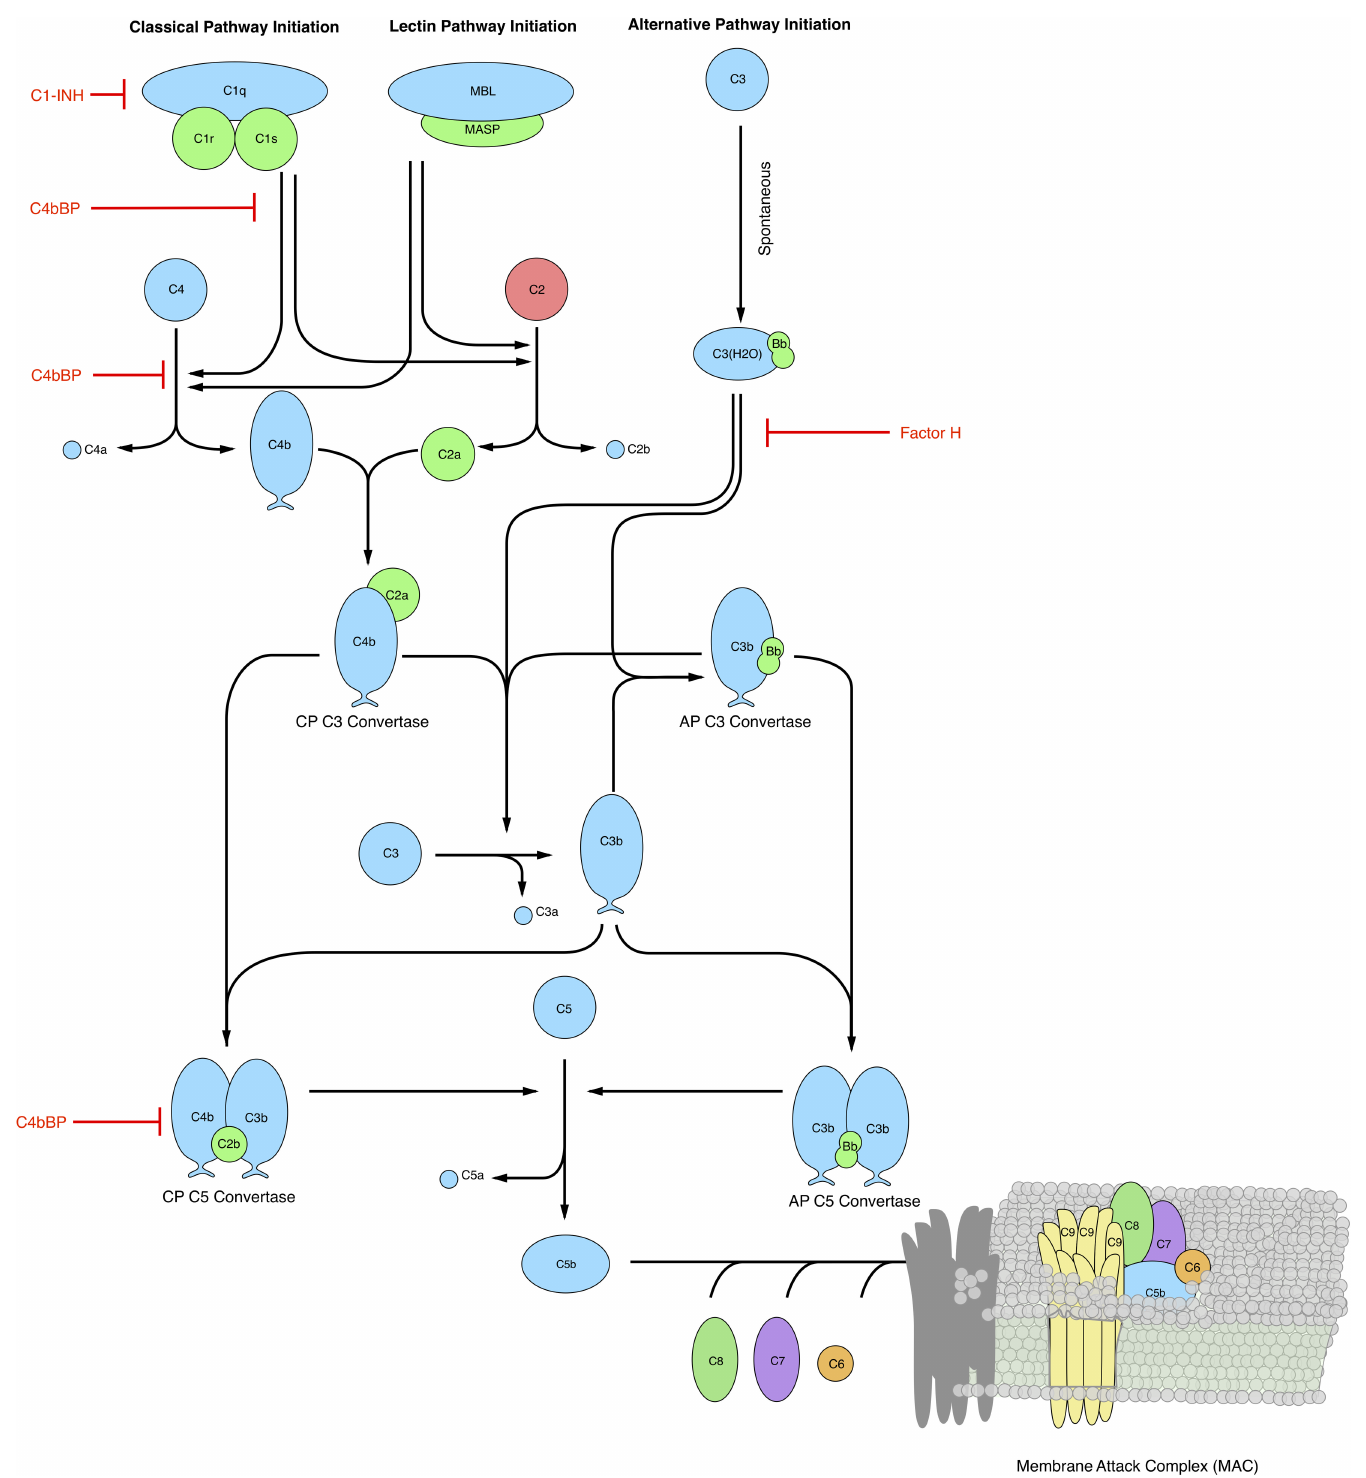
Fig 1. Simplified schematic of the human complement system. The complement cascade is activated through three pathways:the classical, the lectin, and the alternative pathways. Complementinitiationresults in the formation of classical or alternativeC3 convertases, which amplify the initial complement responseand signal to the adaptive immune system by cleavingC3 into C3a and C3b. The C3 convertases further react to form C5 convertaseswhich catalyze the cleavageof the C5 complement protein to C5a and C5b. C5b is critical to the formation of the membraneattack complex (MAC), while C5a recruits an adaptive immune